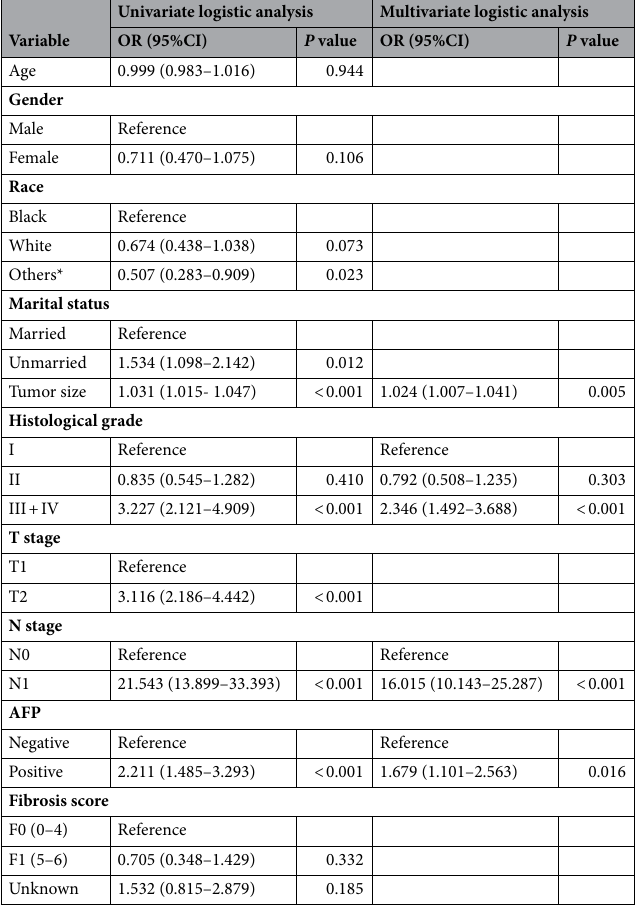
Table 2. Associations of clinicopathological metrics with distant metastasis in small HCC patients. *The others comprise American Indian/Alaska Native, Asian/Pacific Islander. AFP alpha-fetoprotein, HCC hepatocellular carcinoma, OR odds ratio, CI confidence